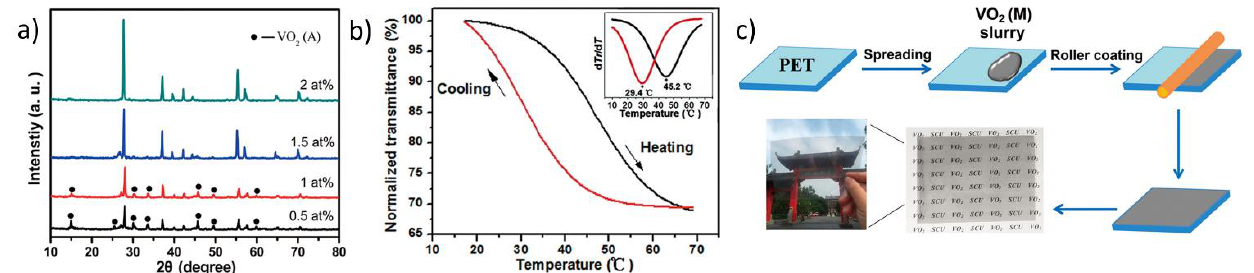
Figure 12. ( a ) XRD patterns of W doped VO 2 (M) films, ( b ) Transmittance hysteresis loops and first derivatives of trans- mittance for W doped VO 2 (M) films recorded at a wavelength of 9 μm, ( c ) Schematic diagram of film deposition with W doped VO 2 (M) NPs on PET substrates. Reproduced with permission from [49] . Copyright 2016, American Chemical Soci- ety.